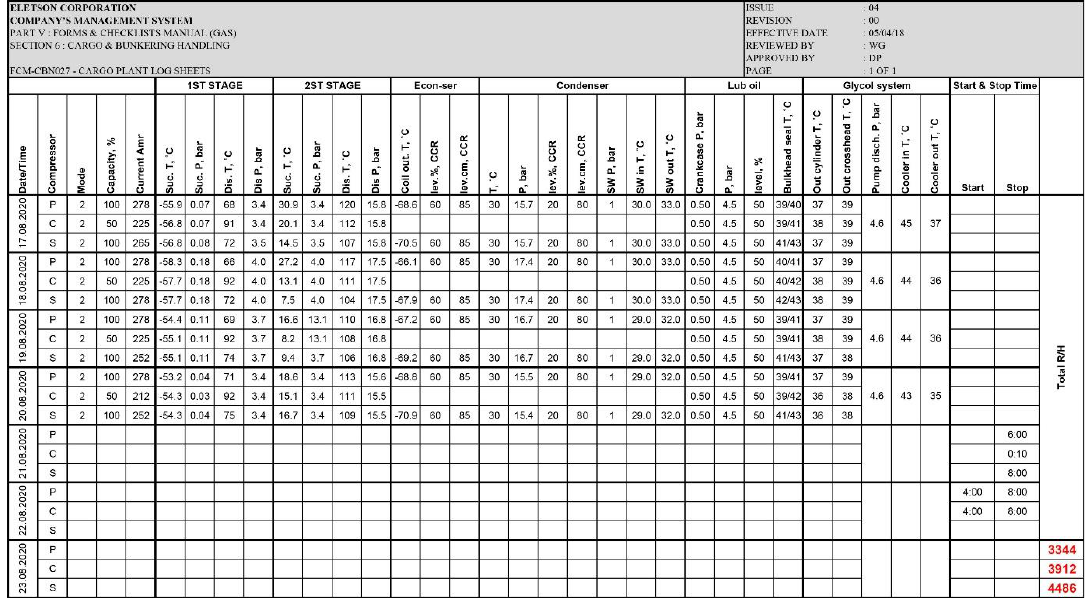
Figure 2. Real-time monitoring of the cargo operation (cargo plant log sheet).